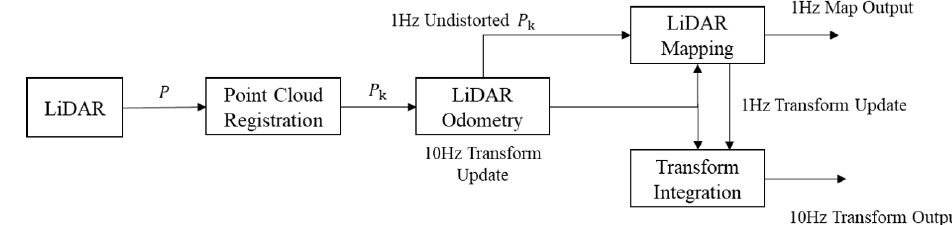
Figure 1. System structure diagram of the LOAM